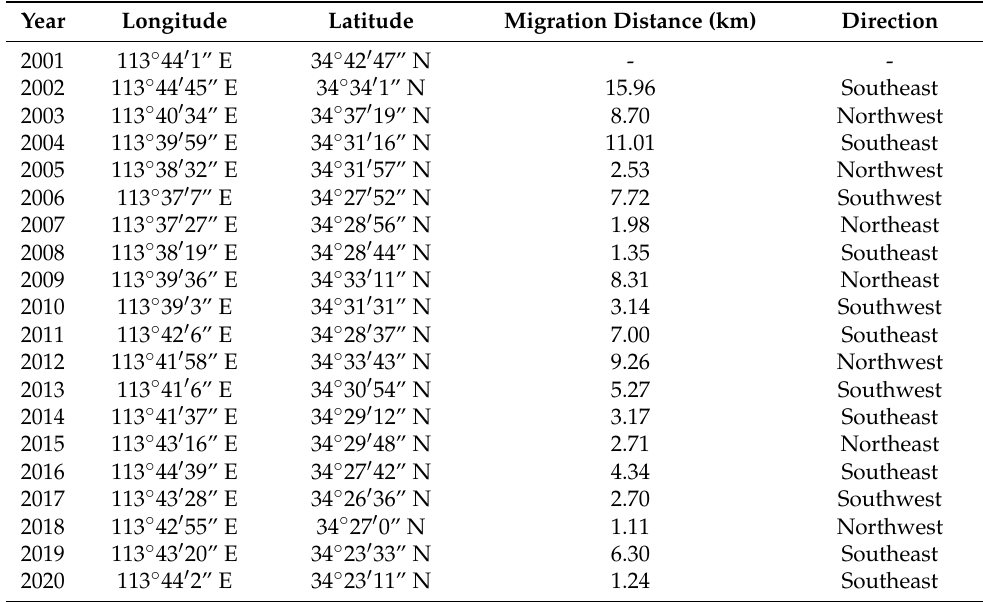
Table 3. Henan Province information from 2001–2020 on the parameters of the economic